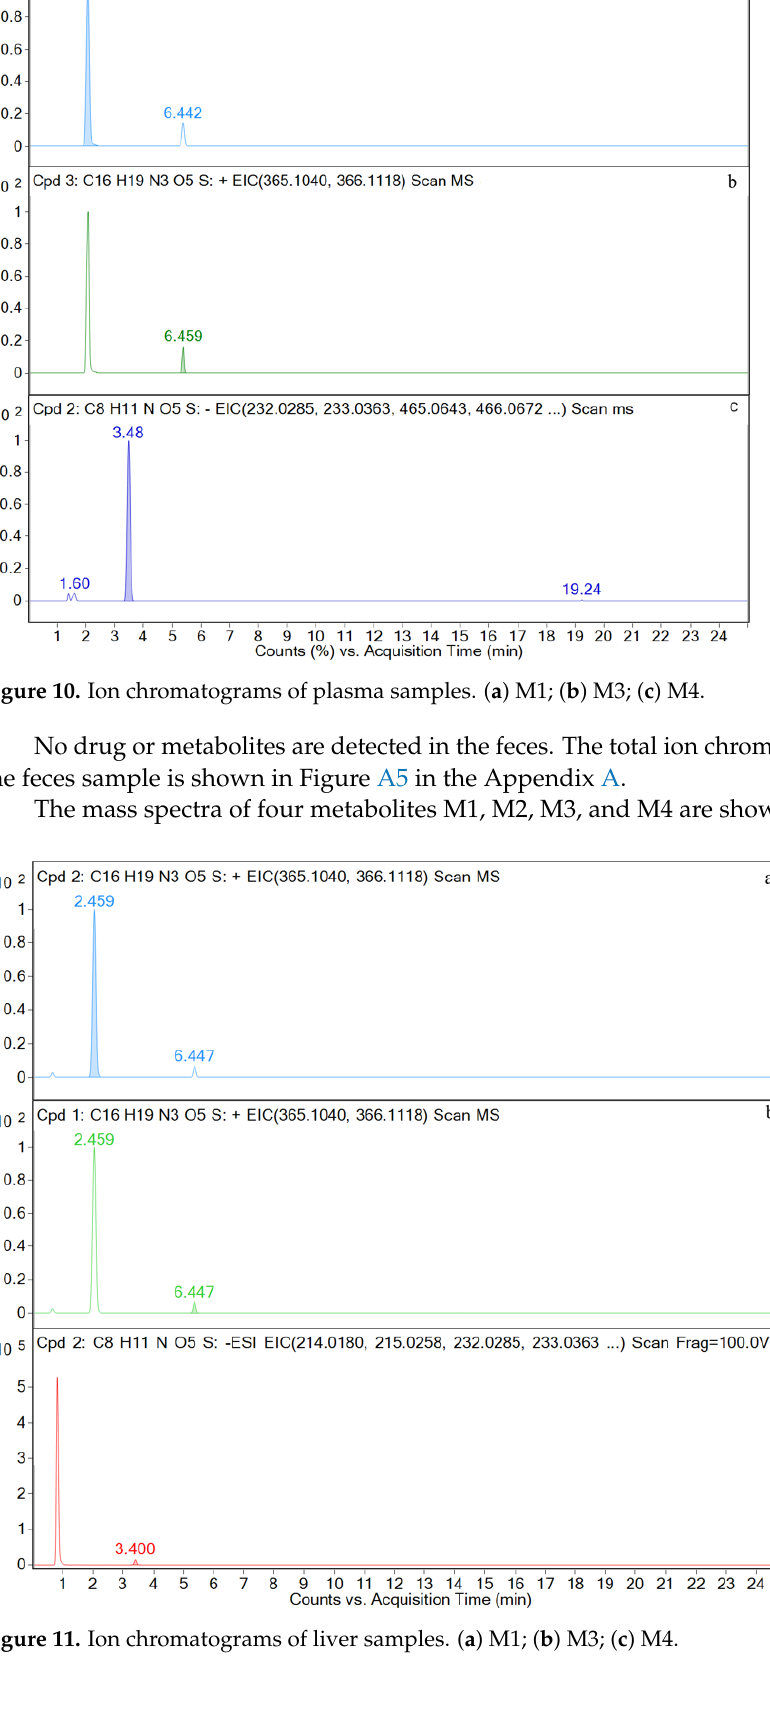
Figure 9. Ion chromatograms of kidney samples. ( a ) M1; ( b ) M3; ( c ) M4. M1, M3, and M4 are detected in the plasma samples. The EIC and TIC for the plasma sample are shown in Figure 10 and Figure A3 in the Appendix A, respectively.